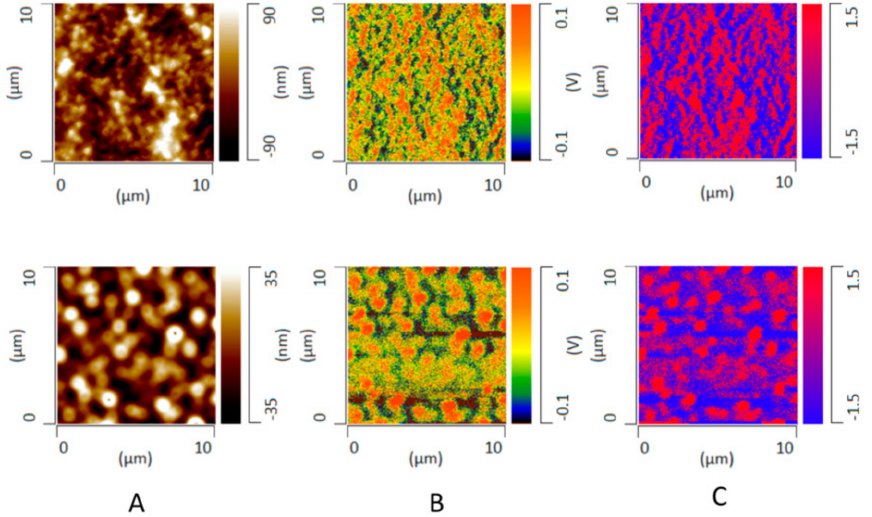
Figure 13. AFM nanoIR images of 30% DL felodipine-PVPVA ASD films, without TPGS (top panel) and with 10% TPGS (bottom panel), after storing in a water-saturated chamber for 12 h: ( A ) topo- graphical image, ( B ) IR image at 1213 cm − 1 , and ( C ) IR ratio image (1213 cm − 1 /1243 cm − 1 ), where red areas are